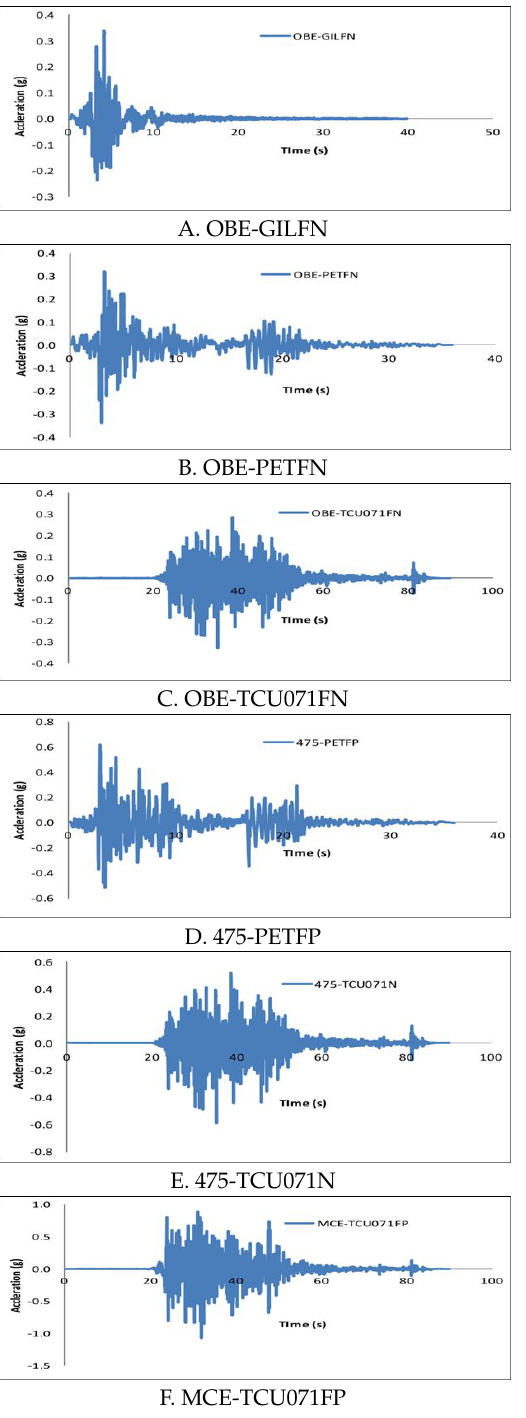
Fig. 1. (A, B, C, D, E, F) : Input time histories for earthquake.